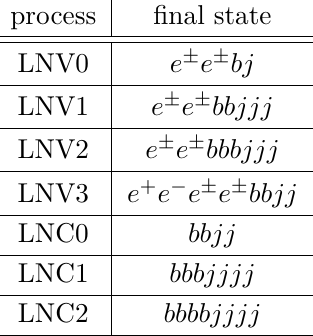
Table 2 . Final states produced by the various LNV and LNC NP